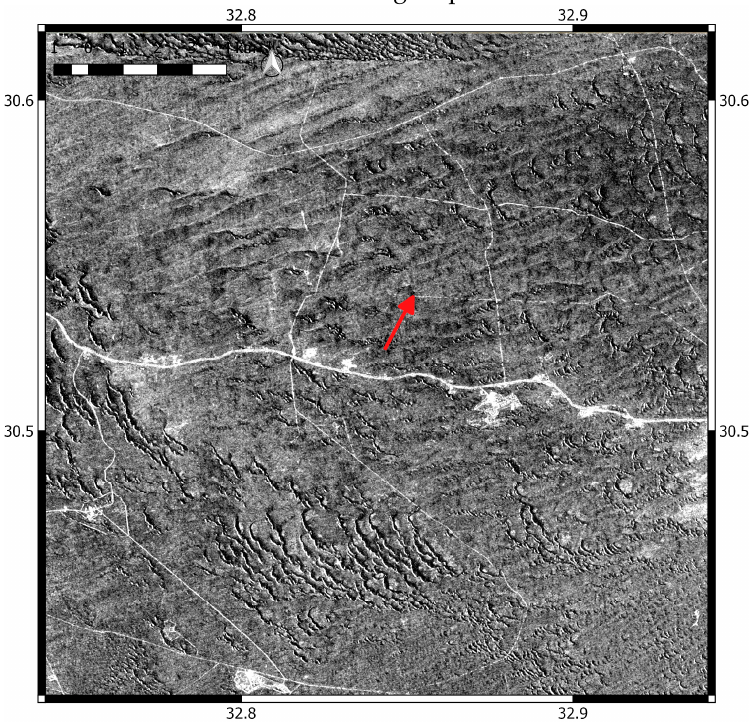
Figure 8. The Sentinel–1 average vertical transmit–vertical receive (VV) backscatter used as an input to the model for North Sinai. The area is the same as that of Figure 7. Contains modified Copernicus Sentinel–1 data 2020.